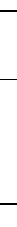
36.620 Figure 17. The controlled intakes with wall static pressure variations at different contraction ratios (X/L = 0.7). 4. Conclusions In the present study, the efficacy of wall ventilation (a shallow cavity having a truncated rectangular cross-section deployed on the core of the intake) in controlling the SBLIs in a Mach 2.2 mixed-compression intake, has been examined experimentally. A parametric study was carried out